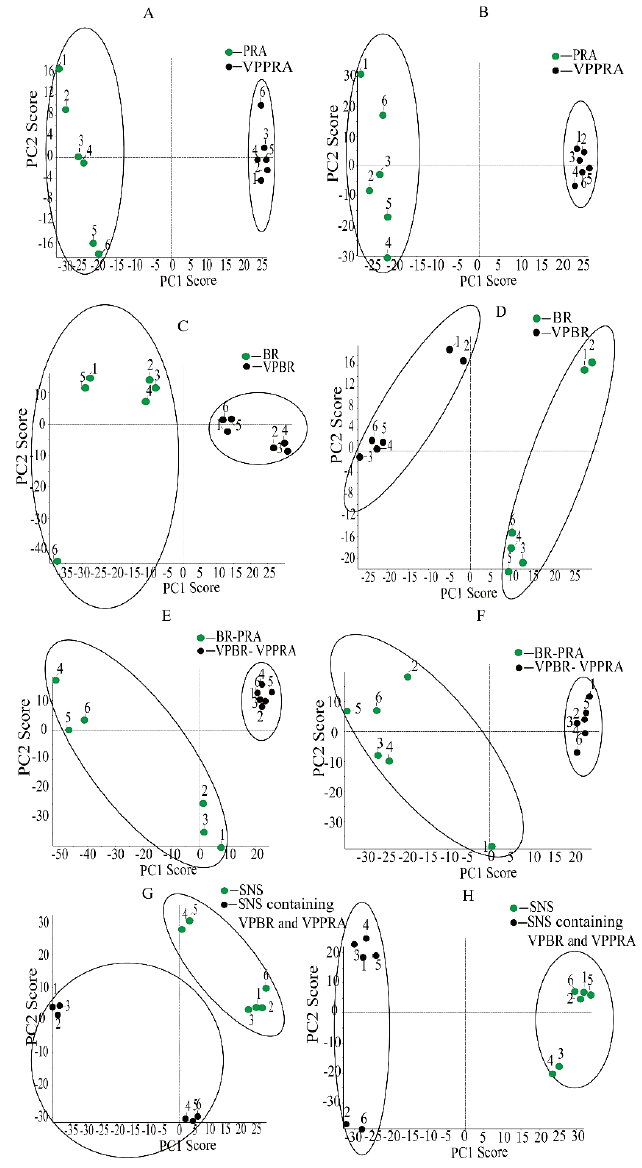
Figure 2. Principal component analysis (PCA) score plots in positive ion mode of PRA and VPPRA ( A ), BR and VPBR ( C ), BR-PRA herb-pair and VPBR-VPPRA herb-pair ( E ), SNS and SNS containing VPBR and VPPRA ( G ). PCA score plots in negative ion mode of PRA and VPPRA ( B ), BR and VPBR ( D ), BR-PRA herb-pair and VPBR-VPPRA herb-pair ( F ), and SNS and SNS-containing VPBR and VPPRA ( H